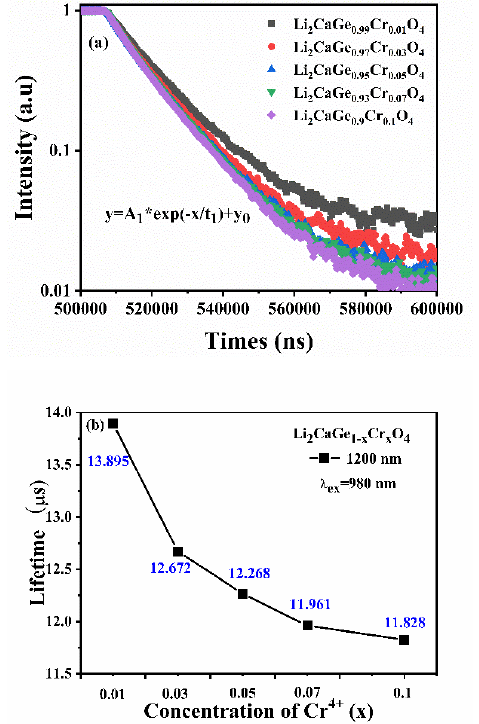
Figure 11. ( a ) Fluorescence lifetime curve of Li 2 CaGe 1 − x Cr x O 4 (x = 0.01, 0.03, 0.05, 0.07, and 0.1); ( b ) dependence of the decay time of Li 2 CaGe 1 − x Cr x O 4 on the Cr 4 + doping concentration.